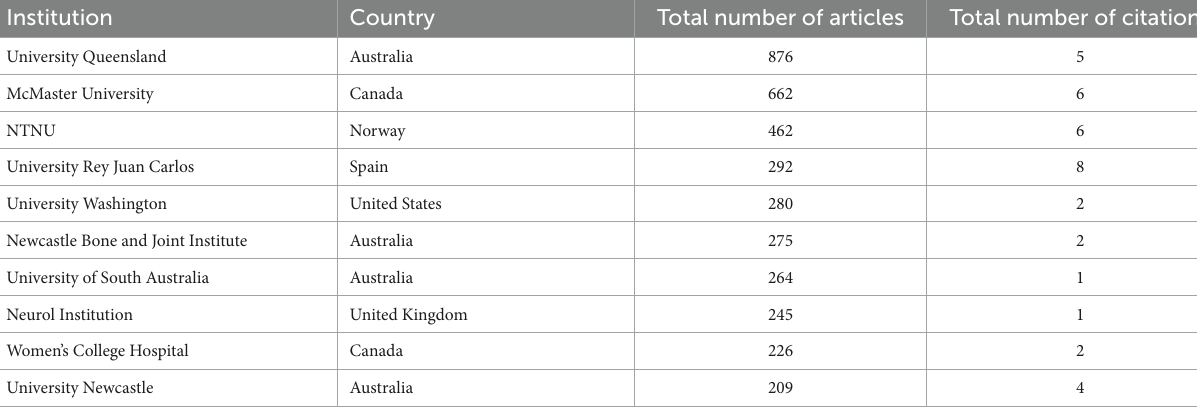
TABLE 2 Top 10 institutions based on total citations in CEH-related